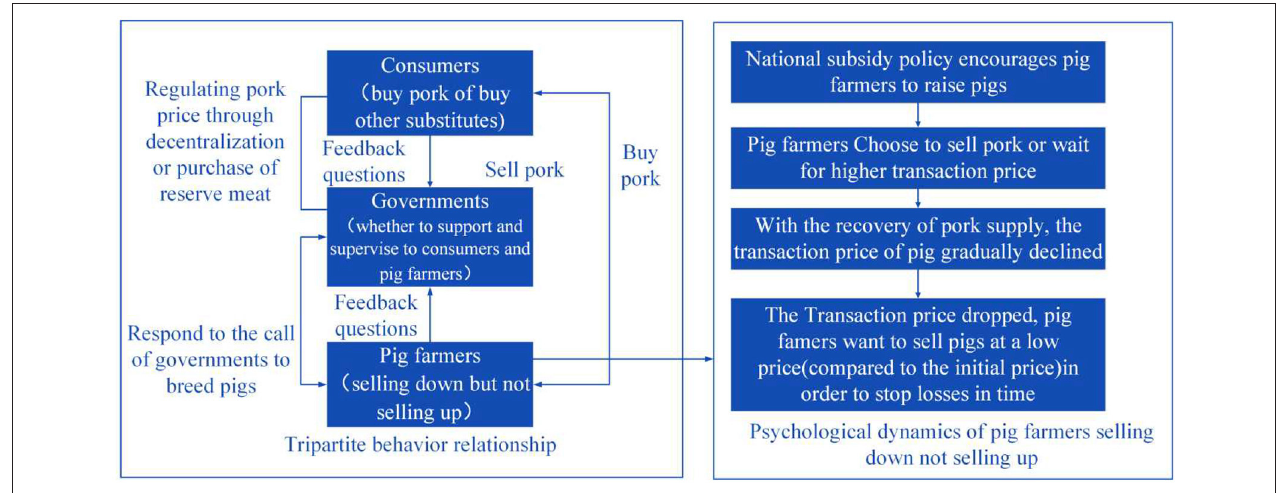
FIGURE 1 | Behaviour relationship among consumers, government, and pig farmers.